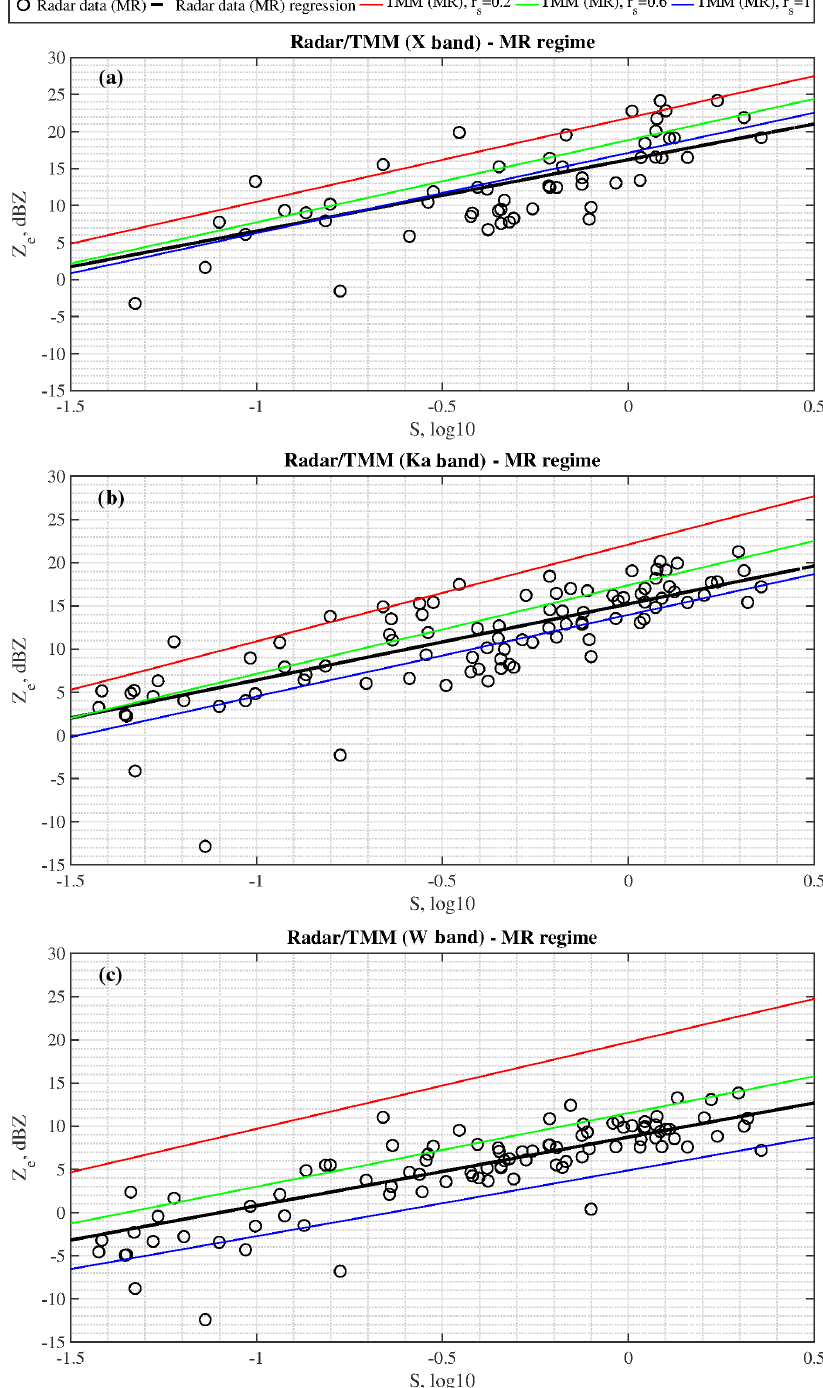
Figure 5. Same as Fig. 4 but for moderately rimed (MR) snowfall cases. Scatterplot is now represented by black circles.